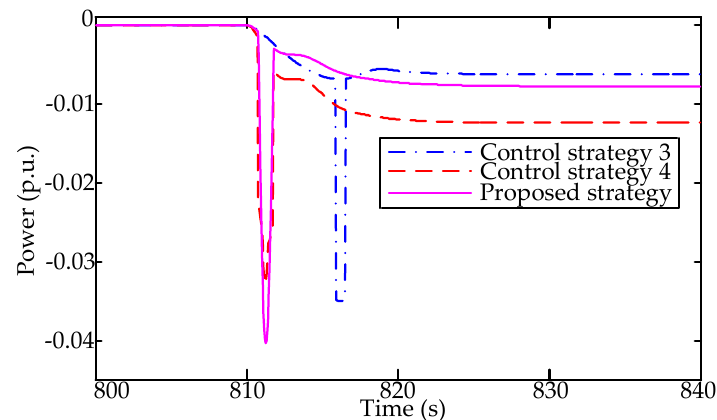
Figure 11. The power output of individual ACs under different allocation strategies.